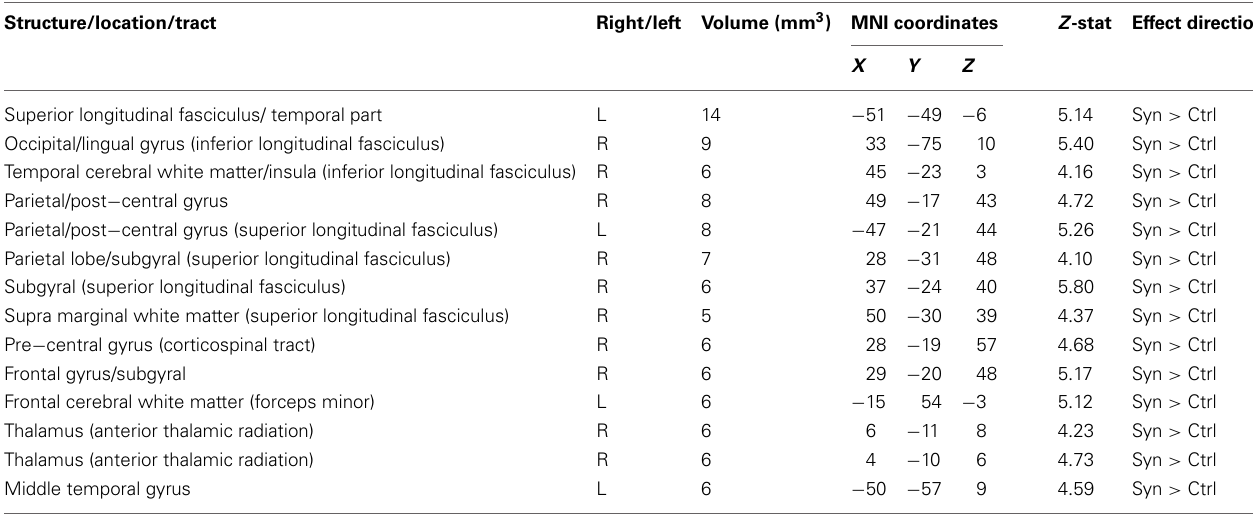
Table 3 | White matter fractional anisotropy FA (whole brain analysis).